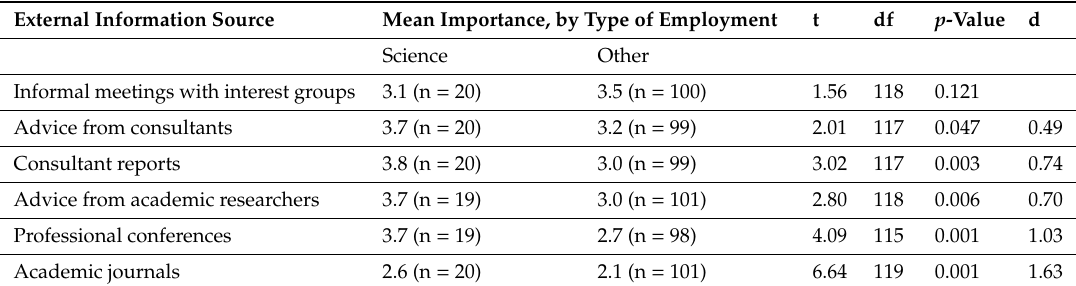
Table 2. The e ff ect of type of employment on importance of external information